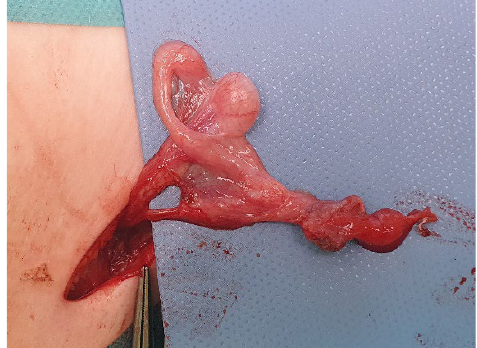
Figure 2. A boy with right canalicular undescended testis: orchiopexy at 13 months of age—a testis with the complete separation of epididymis (caput and cauda) and “long looping” vas deferens is visible.